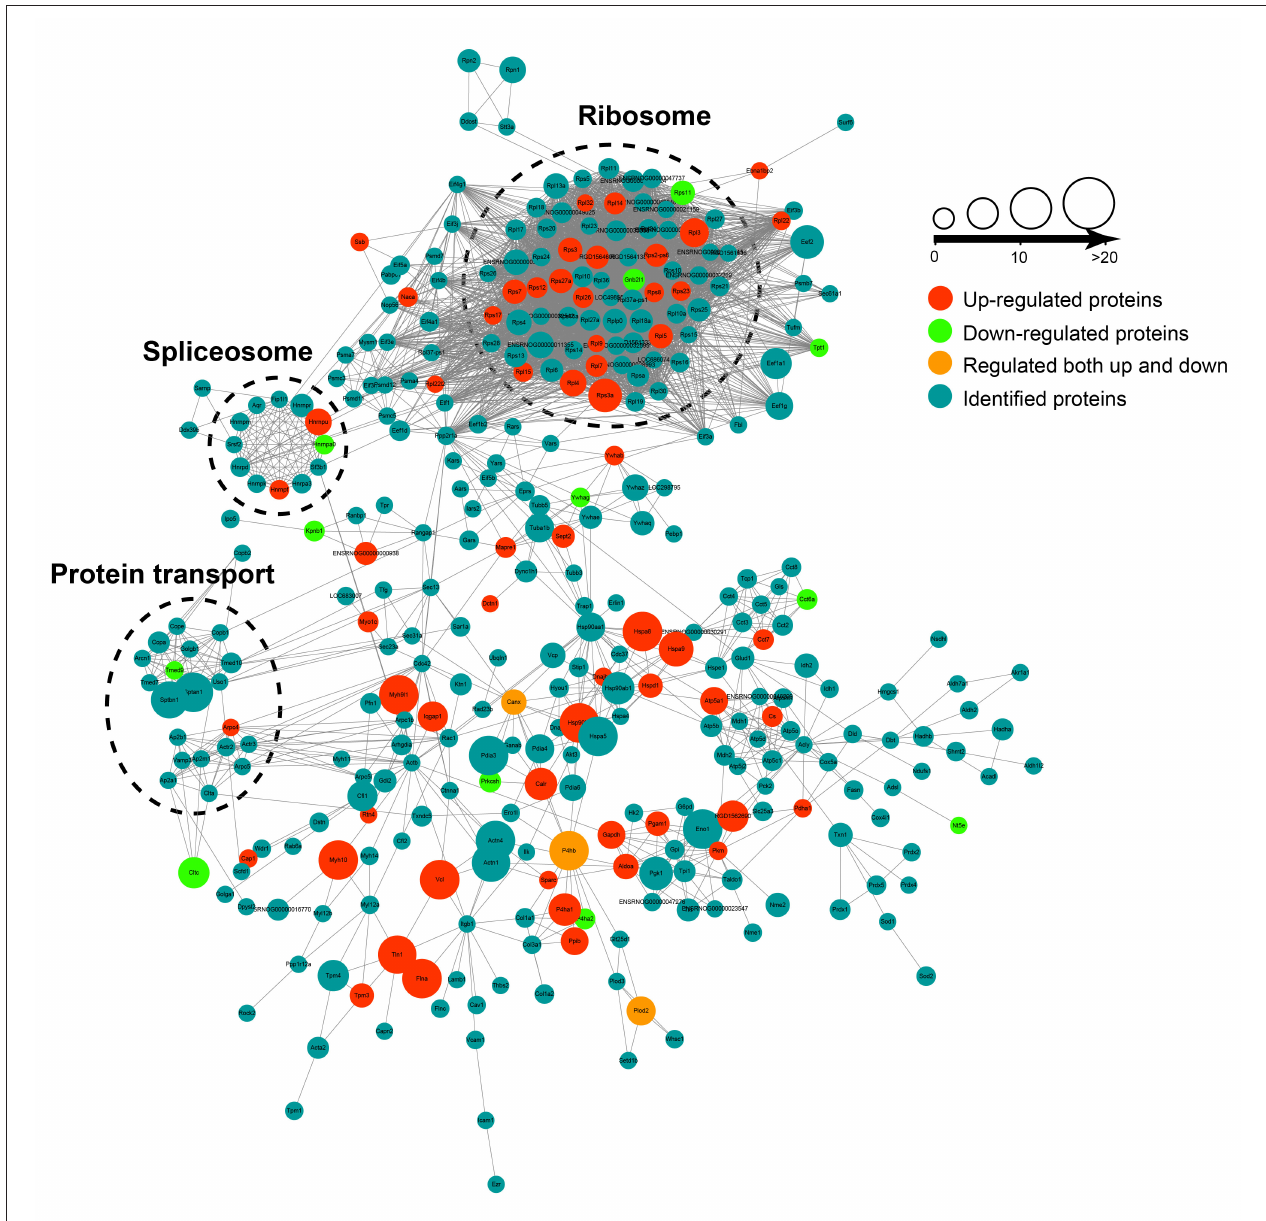
FIGURE 3 | The protein-protein interaction (PPI) network was built according to the STRING database. Interactions belonging to the searched data set were